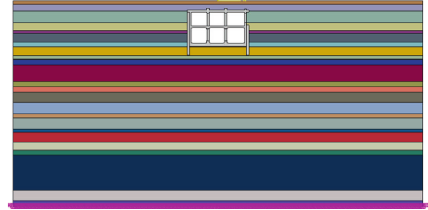
Figure 2: The viscoelastic boundary in the formation-structure Table 2: Relationship between dynamic shear modulus ratio, damping ratio, and shear strain.